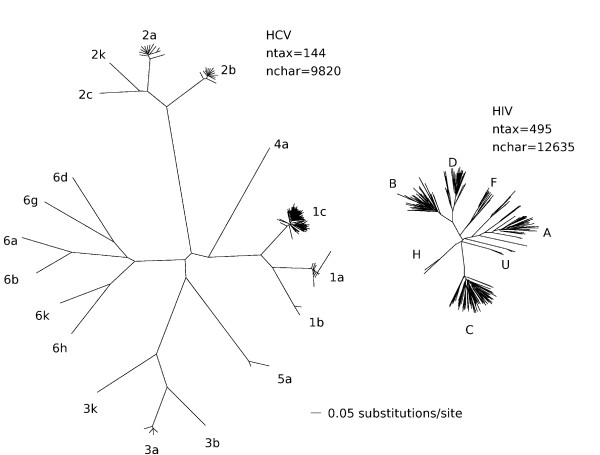
Complete genome trees of the hepatitis C and HIV-1 (M group) viruses. The trees are drawn on the same scale. Only non-recombinant complete genomes have been included. The trees are based on manually curated alignments containing only one sequence per patient. The optimalization method was maximum-likelihood, as implemented in the GAML/Garli program (Zwickl et al. 2005, in preparation).